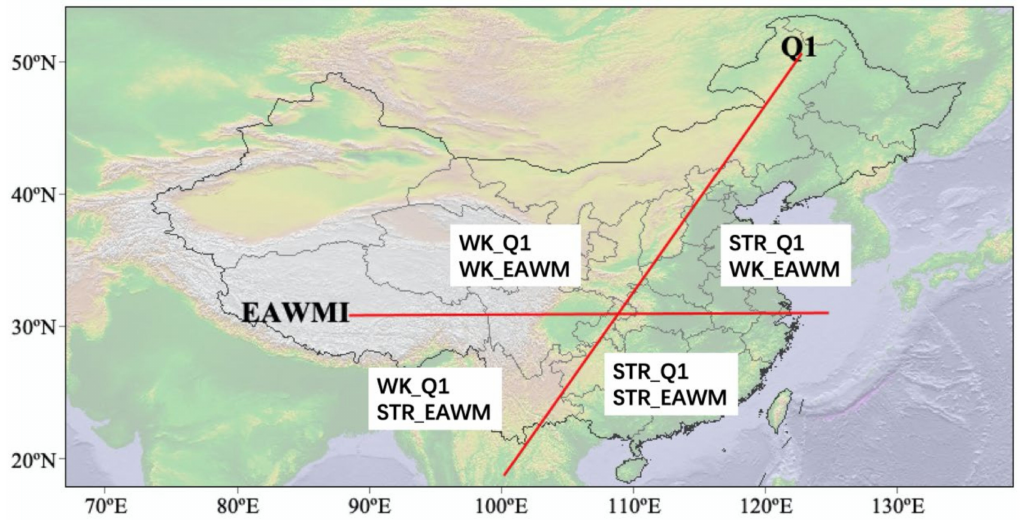
Figure 10. Schematic diagram of different regions in China with the combination of cold sources and strong or weak winter monsoon years.